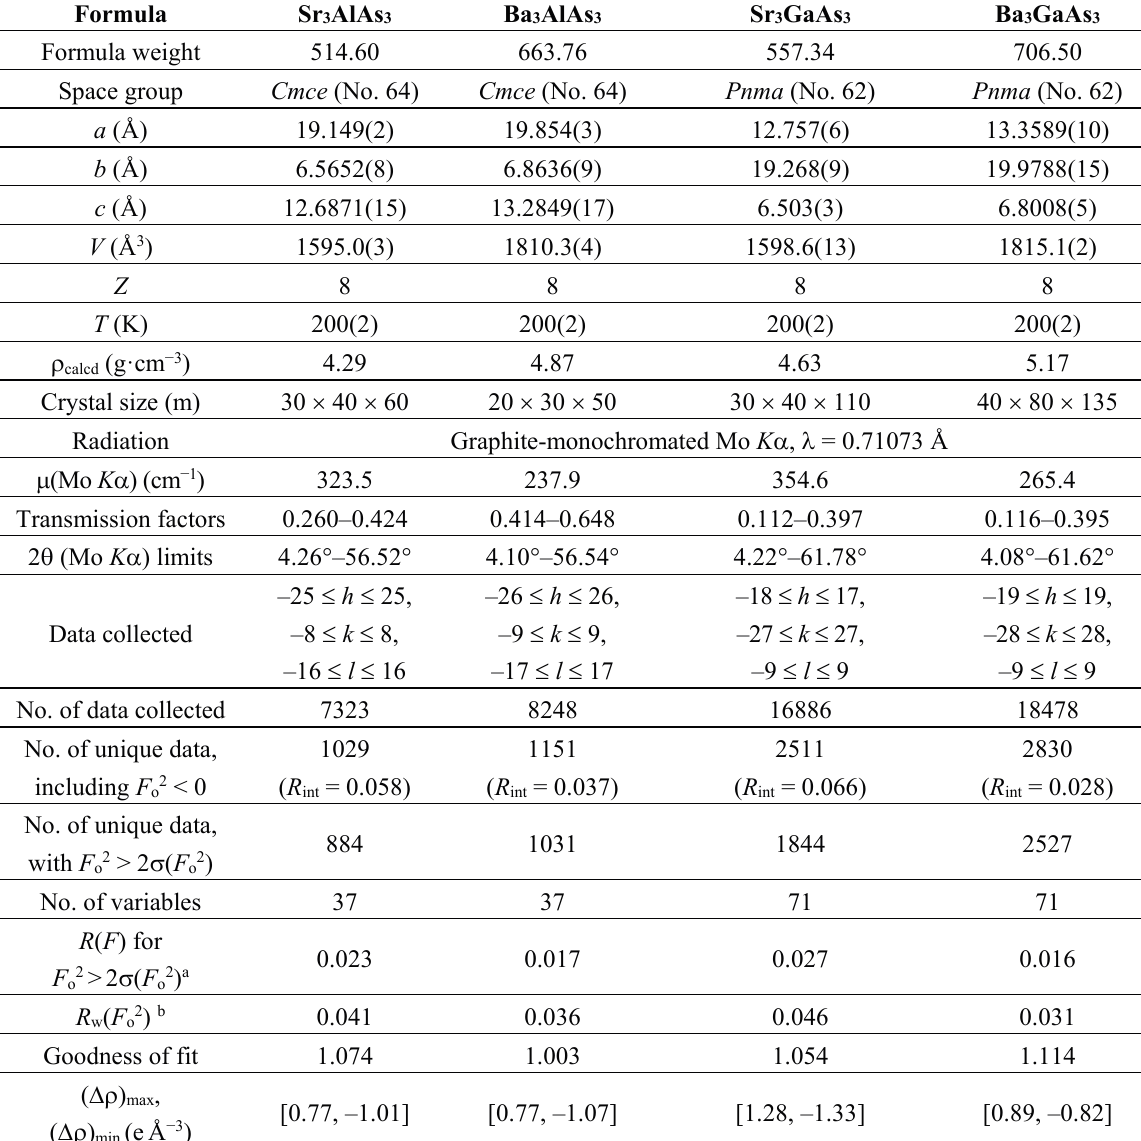
Table 1. Crystallographic Data for AE 3 Tr As 3 ( AE = Sr, Ba; Tr = Al, Ga).